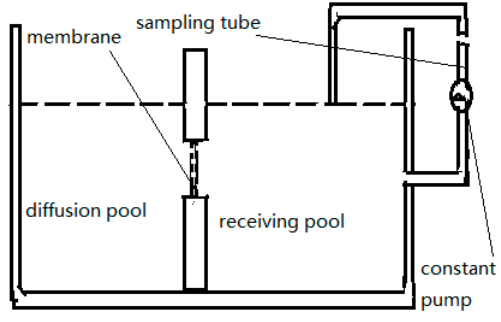
Figure 3. The Ussing chamber.